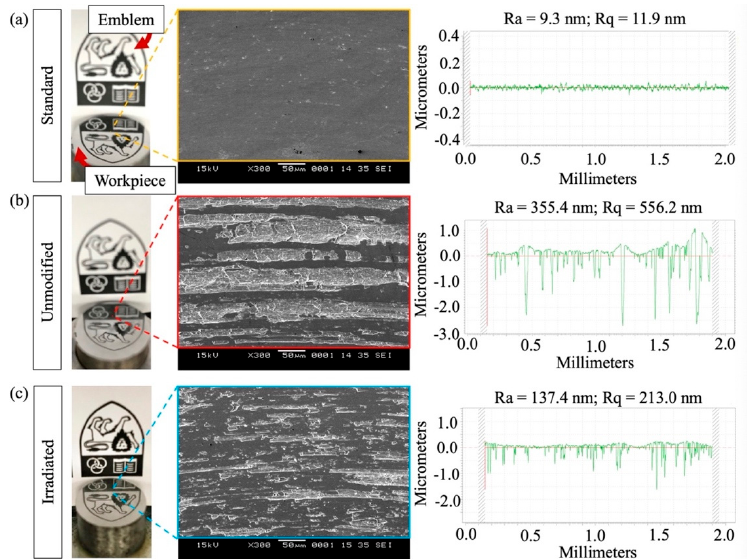
Figure 29. Images of the machined iron surface quality with the magnified observation using a SEM and the respective surface roughness measurements: ( a ) standard requirements achieved after machining 50 m, ( b ) after machining with an unmodified diamond tool over a distance of 350 m, and ( c ) after machining with a gallium irradiated diamond tool over a distance of 350 m, reprinted with permission from Ref. [202] 2019, Elsevier.